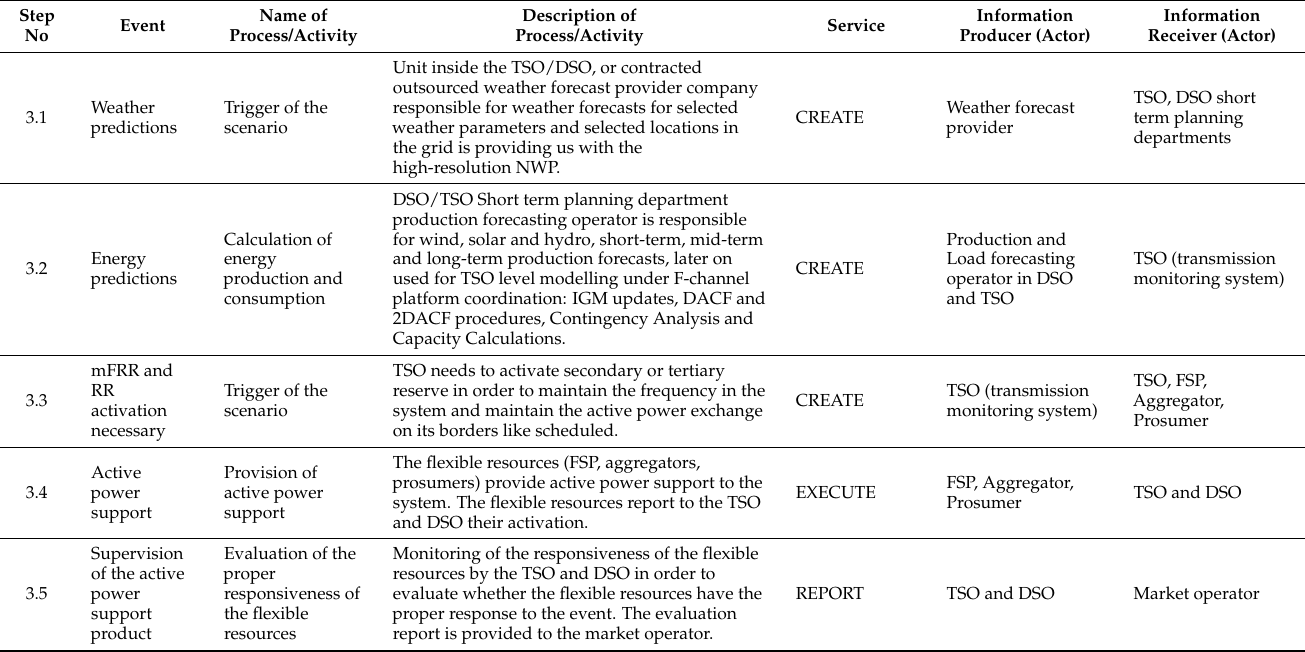
Table 6. Step-by-step analysis of Scenario